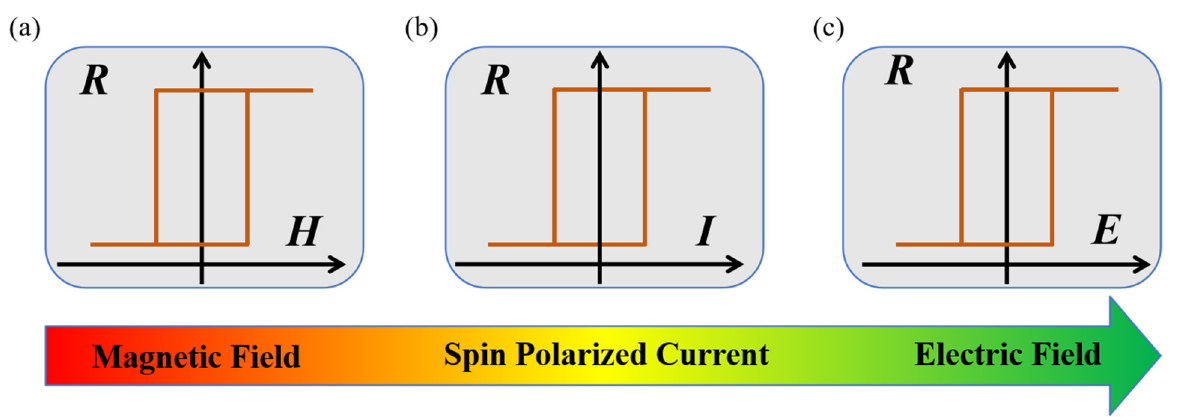
Figure 1. The sketch of magnetic recording prototype evolution. Writing data with ( a ) magnetic field, ( b ) spin polarized current, ( c ) electric field.